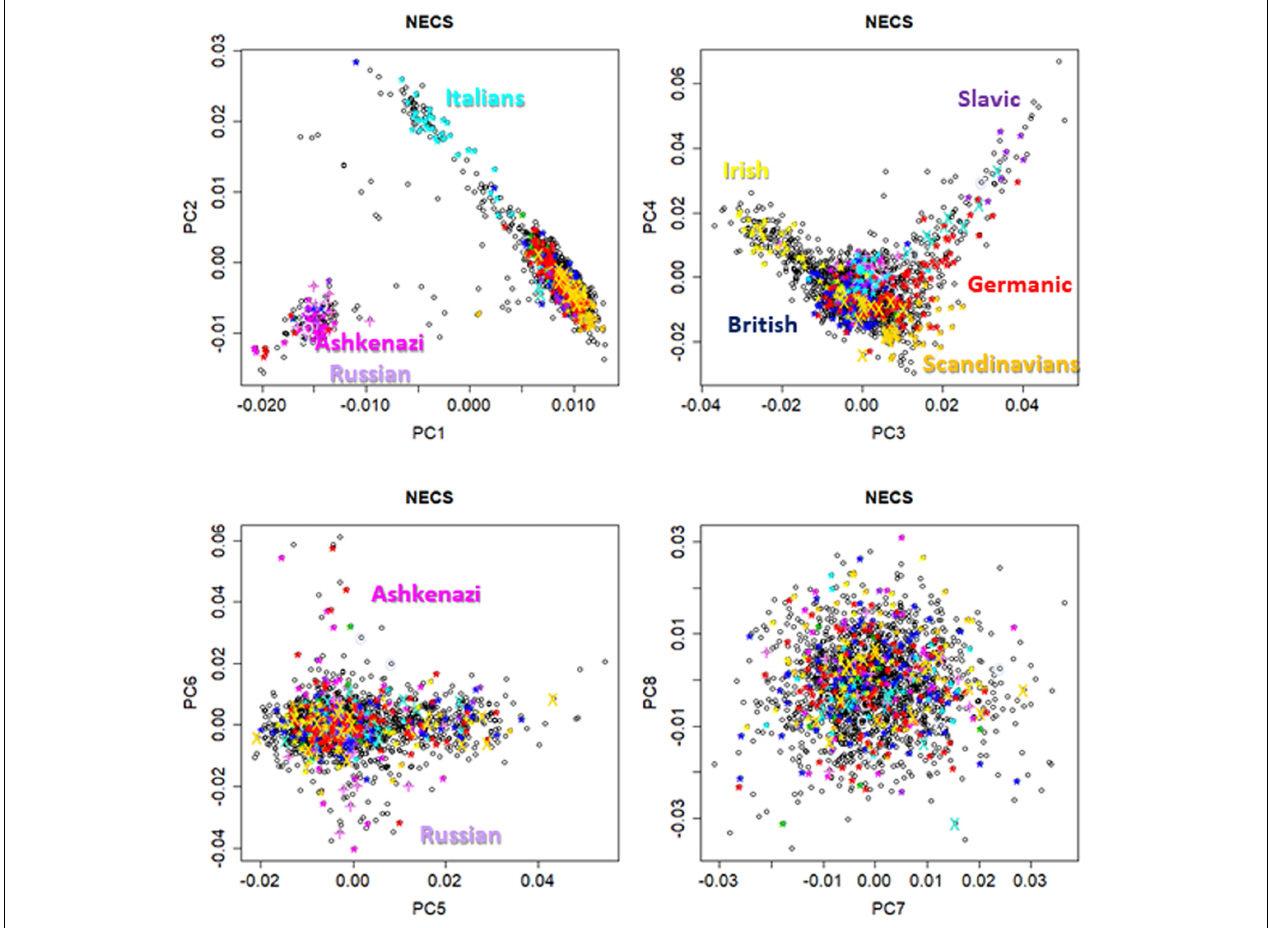
FIGURE 1 | Pairwise scatter plots of the first eight principal components from genome-wide principal component analysis (PCA) in participants from the New England Centenarian Study (NECS). European ethnicities were defined based on parents and grand-parents mother tongue, and birth place.